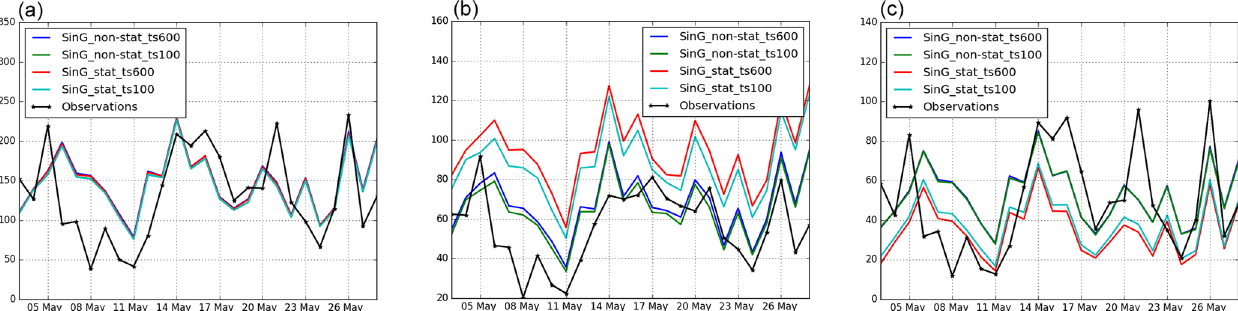
Figure 8. Daily average concentrations of NO x (c) , NO 2 (b) and NO (c) concentrations (µgm − 3 ) calculated by SinG at CELES station with different main time steps using the stationary and nonstationary